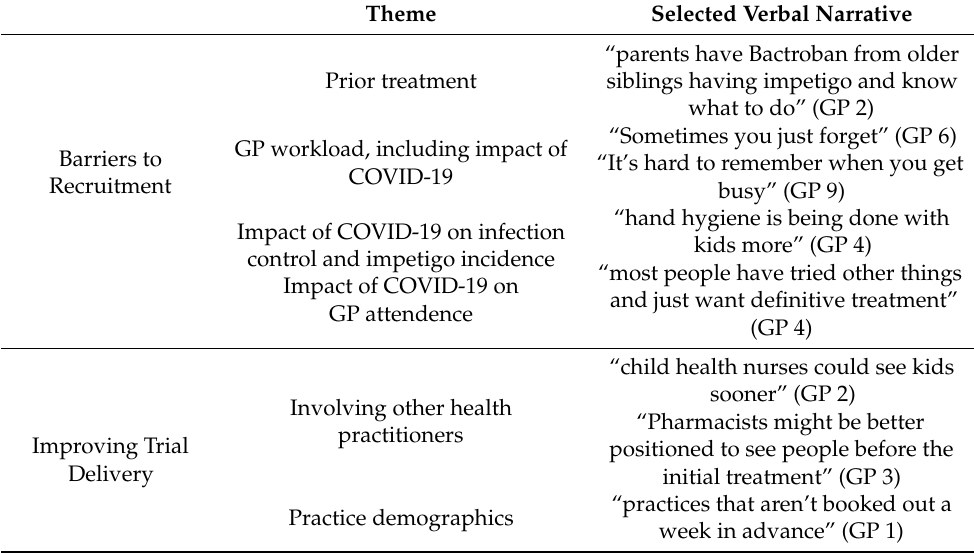
Table 2. Themes resulting from content analysis of post-study interviews with practice